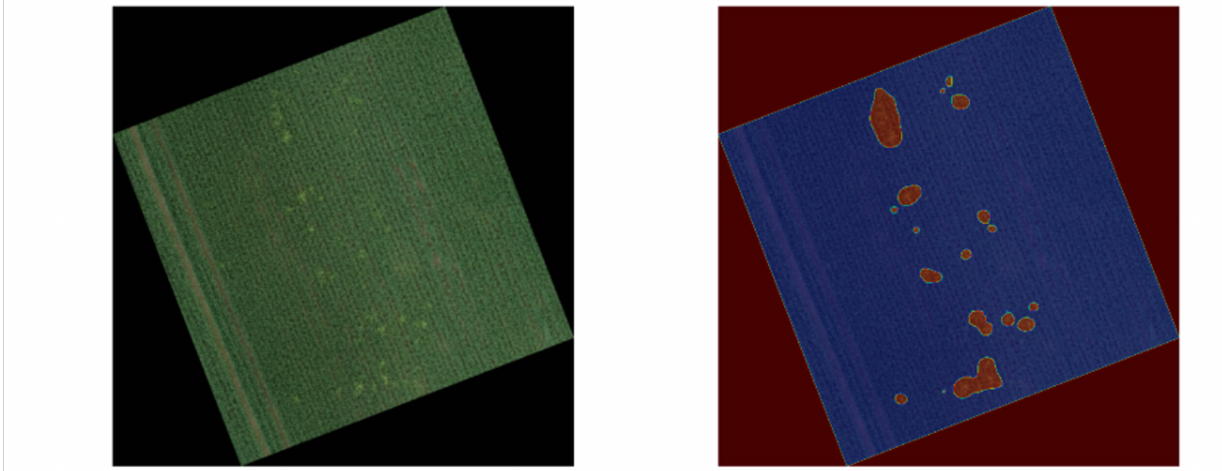
Figure 6. Client dashboard example. Top : clickable weed abundance map based on model predictions and field survey categories (dark green: absent; Light green: low; yellow: medium; orange: high; red: very high). Bottom : weed model prediction on a specific